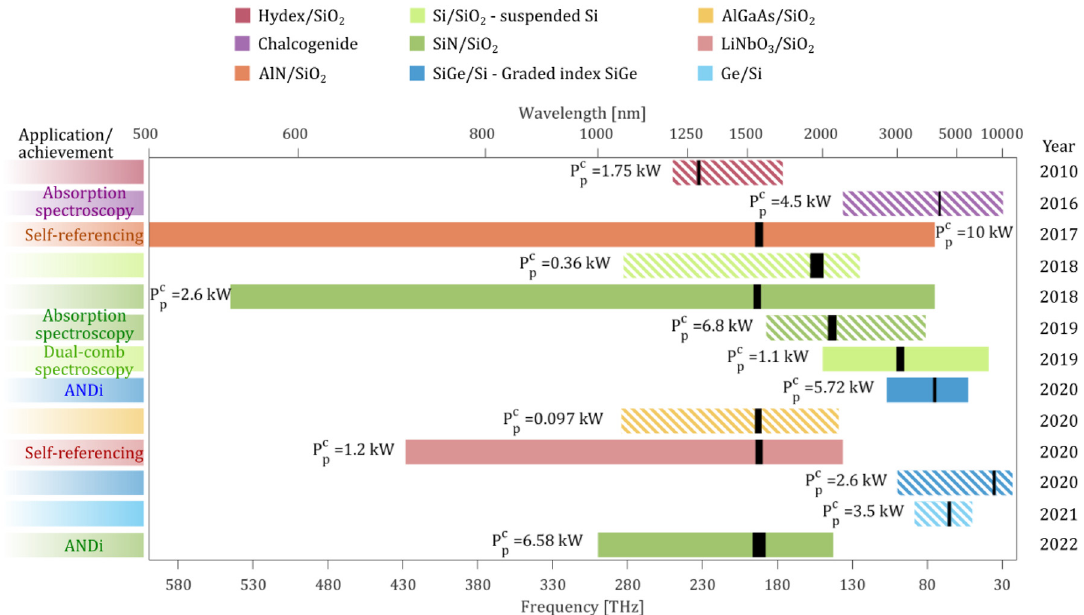
Figure 21: Comparison of selected demonstrations of SCG in integrated platforms (Refs. from top to bottom of the figure: [15, 25, 28, 35, 55–60, 81, 82, 129]). For each result, the width of the colored band indicates the bandwidth of the generated SC, the color indicates the type of platform, and P C the coupled peak power. Unpatterned bands indicate coherent SCG. The black lines represent the pump wavelength/frequency. The bandwidth of the pump was inferred from the pump pulse duration considering transform limited Gaussian